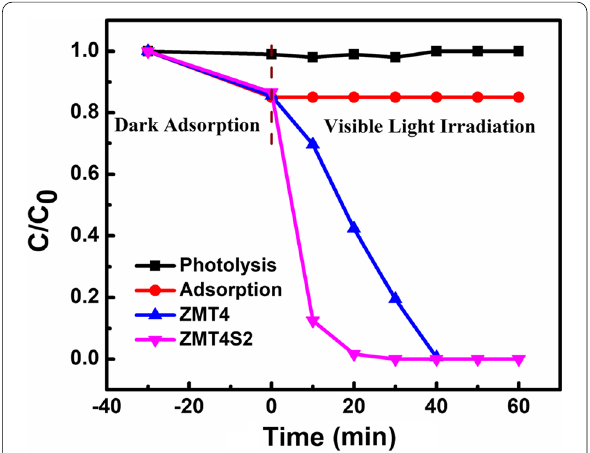
Table 8 Specific scavenging reagents used for identification of reactive